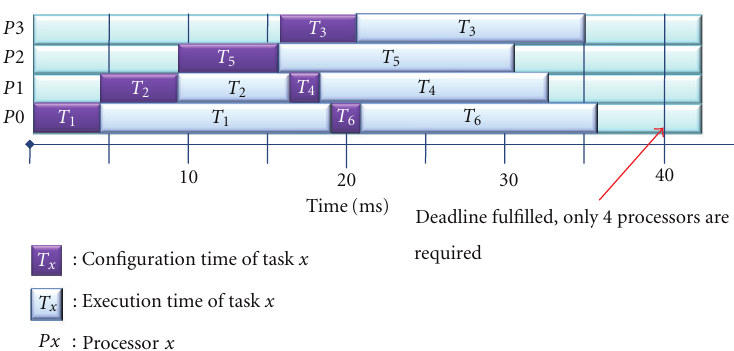
Figure 13: Theoretical results of CAP-OS for the image-processing applications and respecting heterogeneous configuration times.